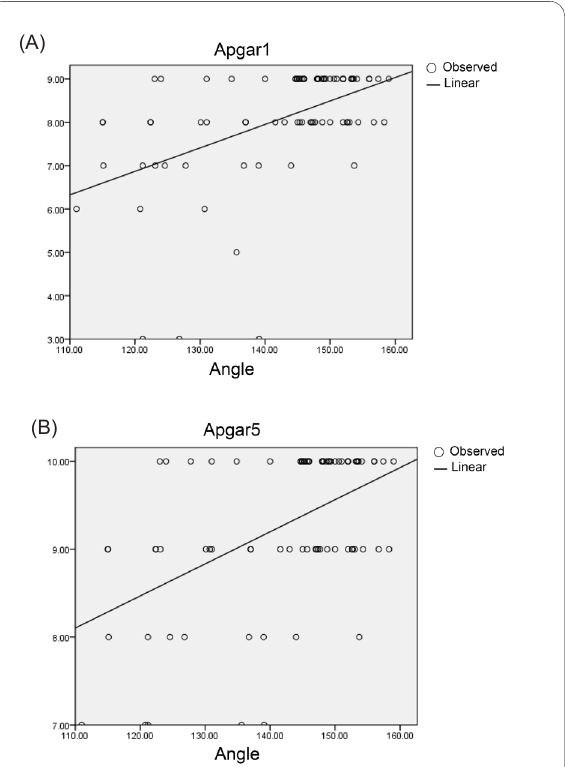
Figure 1. (A) Correlation between angle of progression and Apgar 1. (B) Correlation between angle of progression and Apgar